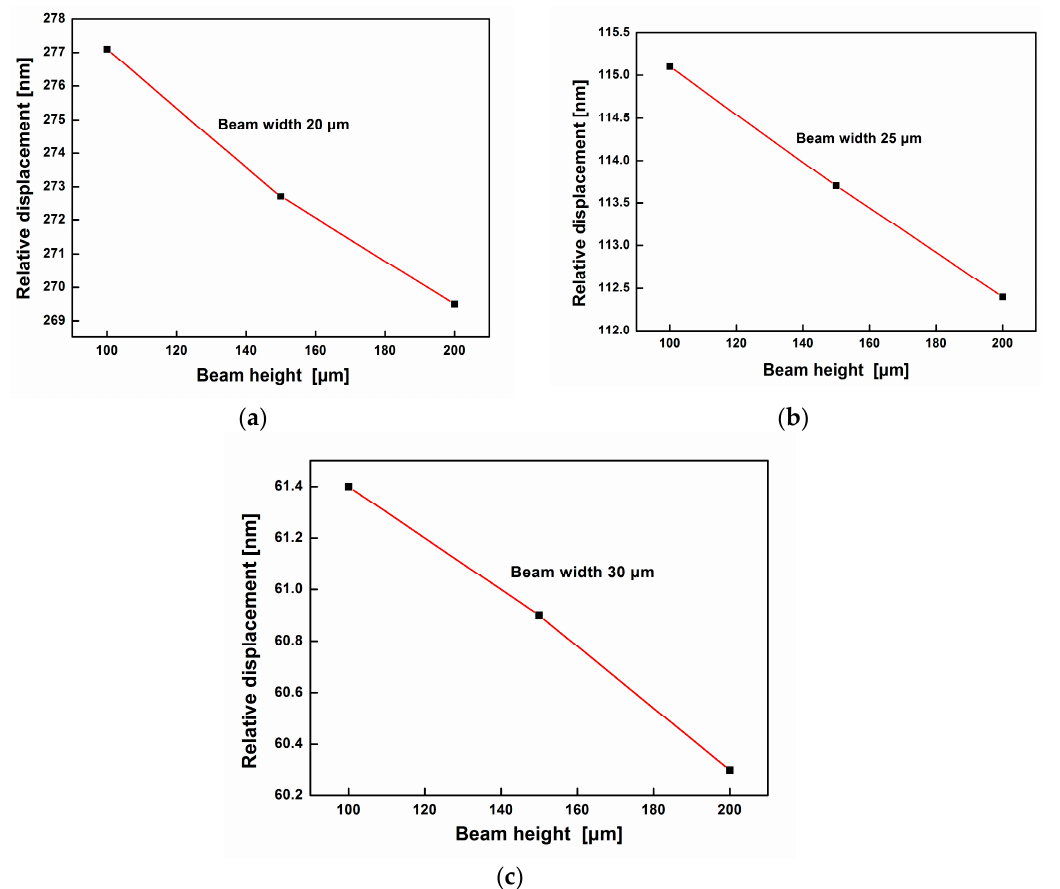
Figure 8. Relative displacement curves with respect to the elastic beam height in different beam widths ( a ) 20 μ m; ( b ) 25 μ m; ( c ) 30 μ m.